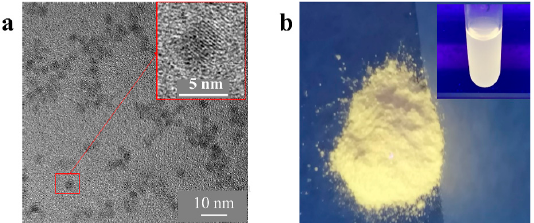
Figure 1. ( a ) TEM images of ZnO QDs. ( b ) Digital photographs for power and aqueous solution (the inset image) of ZnO quantum dots (QDs) under 365 nm UV irradiation.